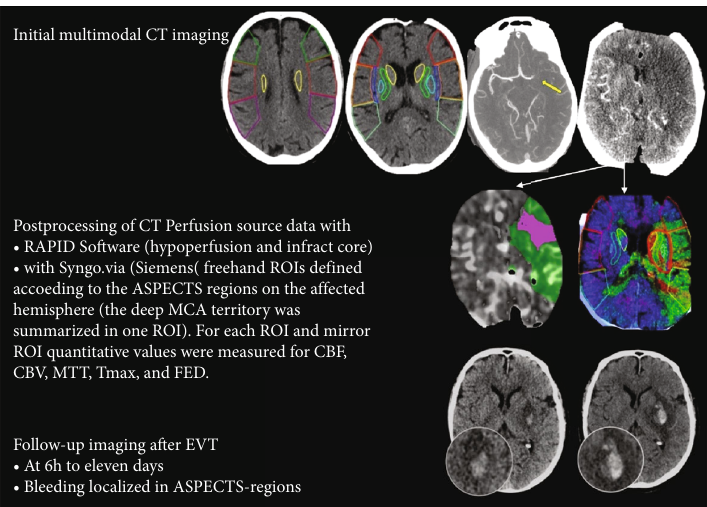
Figure 2: Visualization of the initial imaging, postprocessing of perfusion data, and follow-up. Abbreviations: ASPECTS, Alberta Stroke Program Early CT Score; CBF, cerebral blood fl ow; CBV, cerebral blood volume; EVT, endovascular treatment; FED, fl ow extraction product; MCA, middle cerebral artery; MTT, mean transit time; ROI, region of interest; and Tmax, maximum enhancement